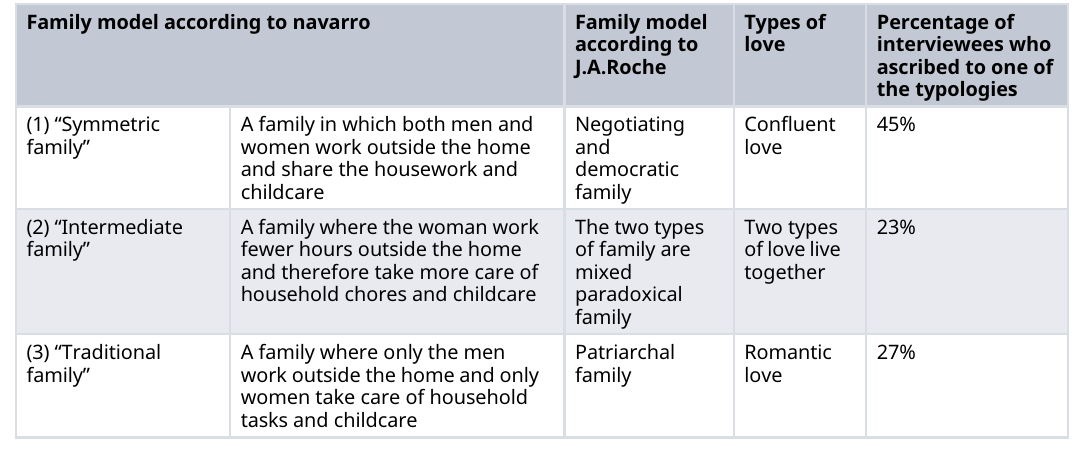
Table 3. Family relationship models. Source: Own elaboration based on Navarro 2006, p.121.